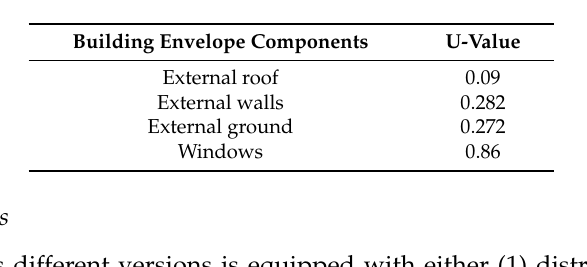
Table 3. U-value of the building used in the